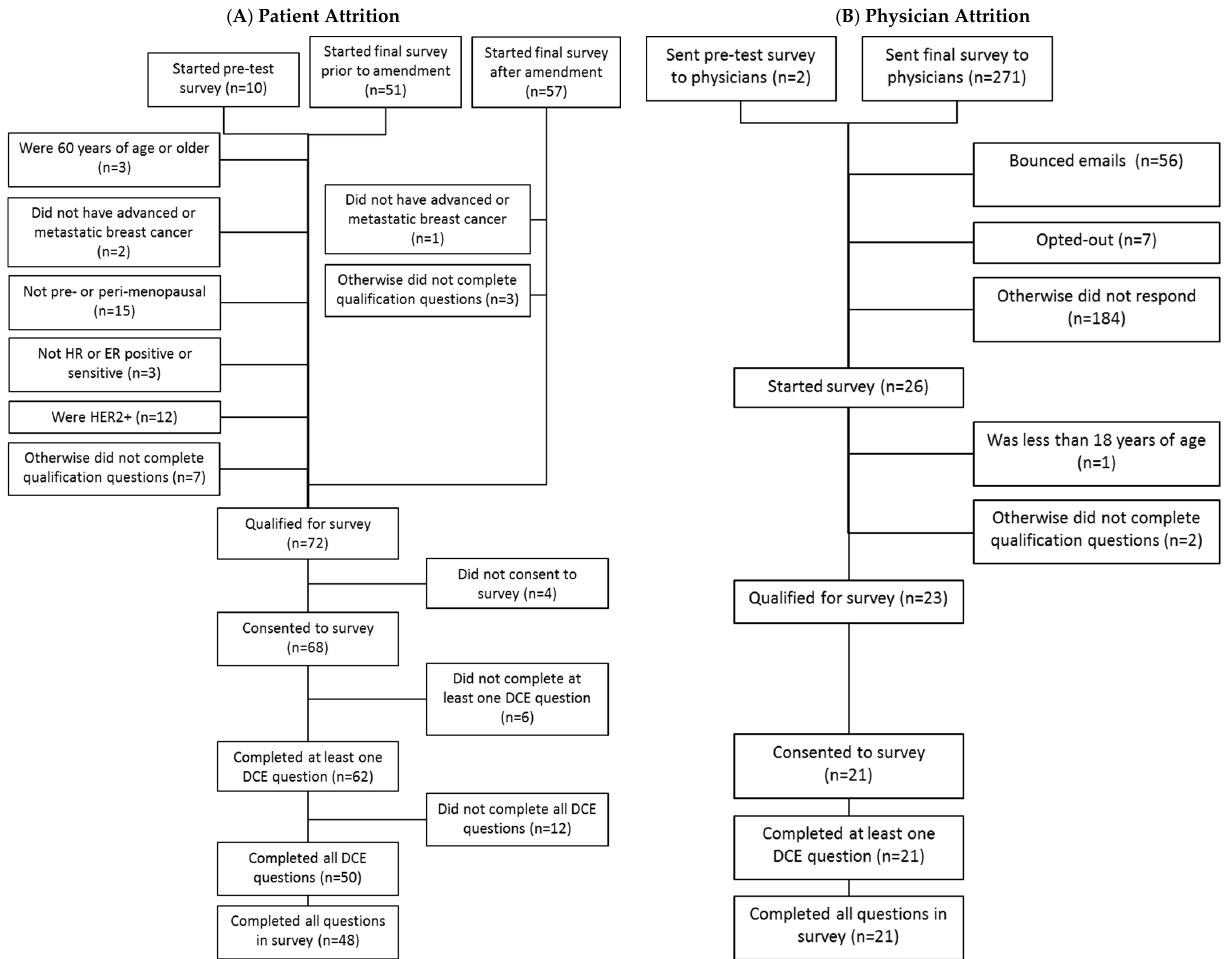
Figure 1. Patient and physician attrition; Note: Numbers in parentheses are numbers of subjects.